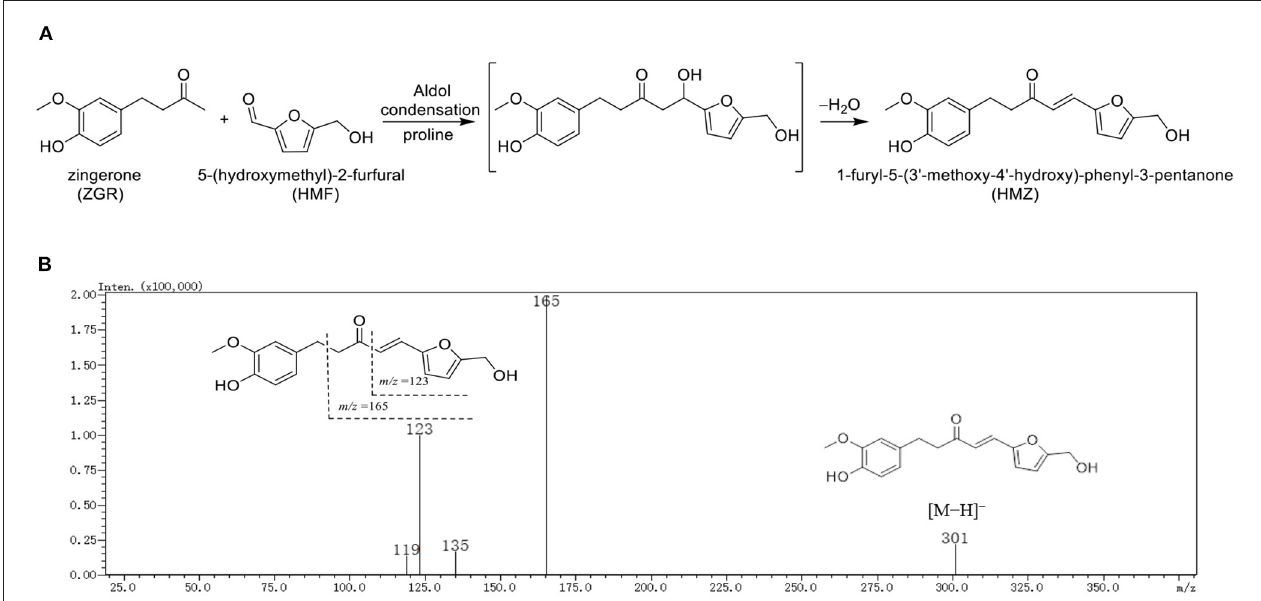
FIGURE 1 | The (A) reaction pathway and (B) MS/MS spectrum of HMZ.